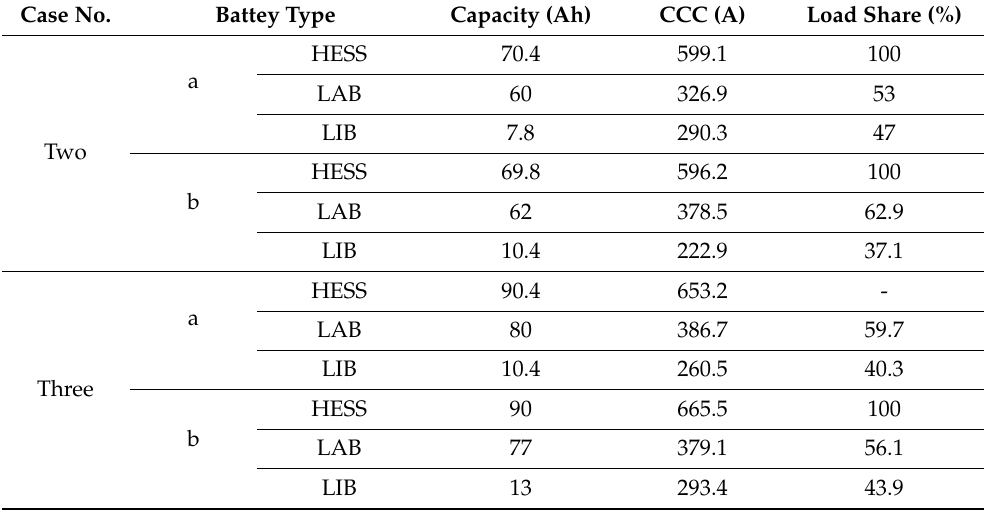
Table 2. A summary of the HESS case results.